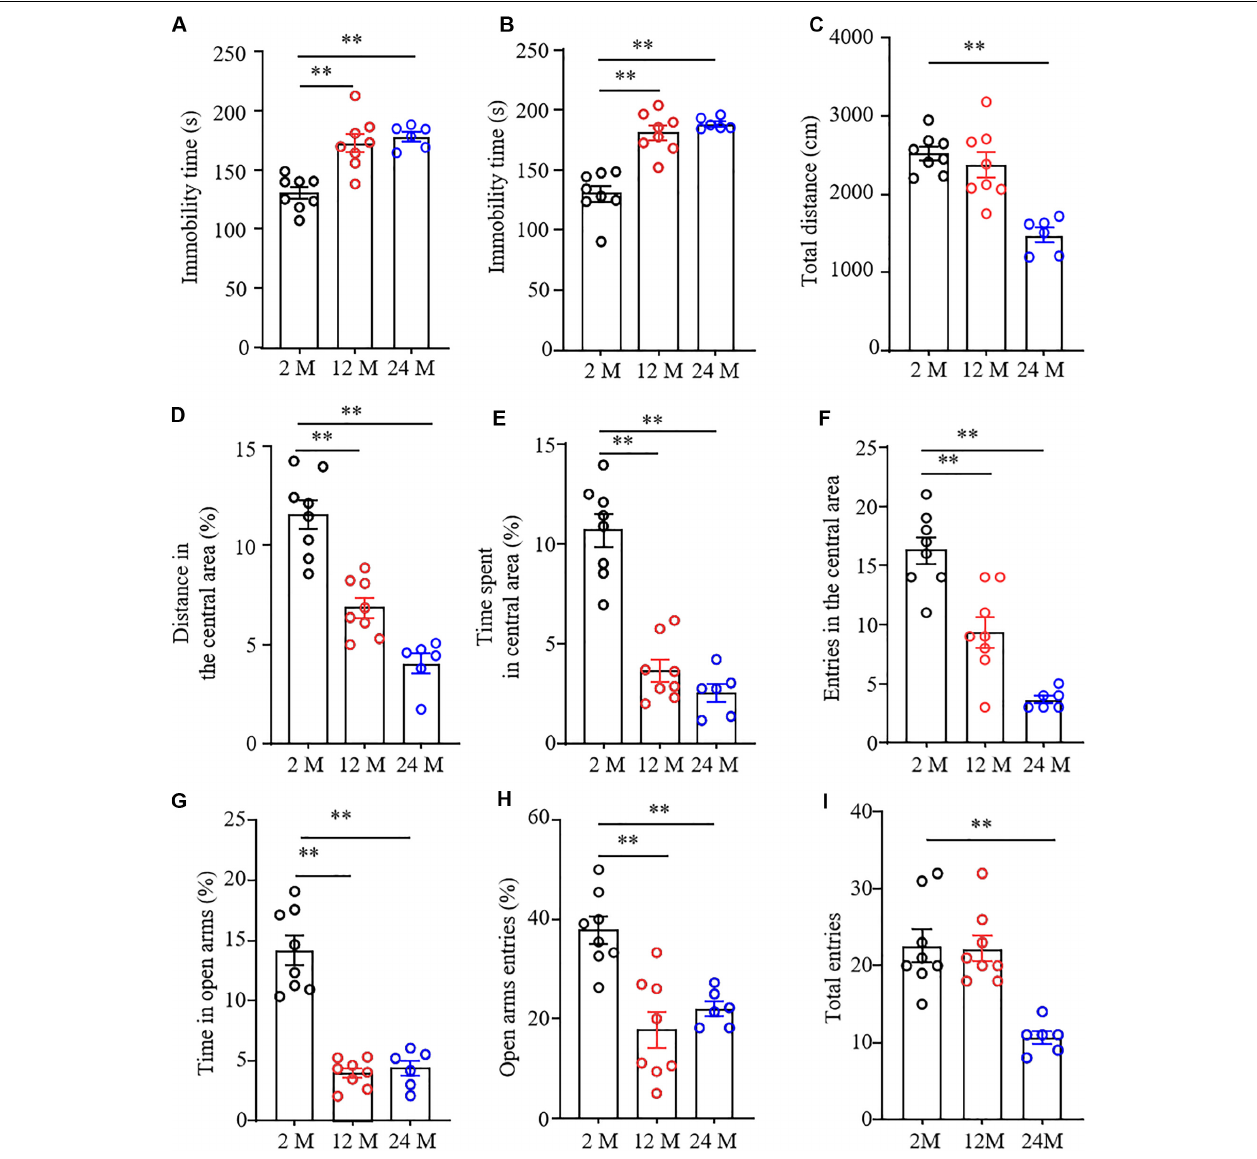
FIGURE 2 | Depression- and anxiety-like behavior in aging mice. n = 8 for 2- or 12-month mice, n = 6 for 24-month mice. Data were shown as mean ± SEM. (A,B) The immobility time was significantly increased in 12- and 24-month old mice in the forced swimming test (FST) (A) and tail suspension test (TST) (B) as compared to 2-month old mice. ∗∗ P < 0.01 versus 2-month old mice by one-way ANOVA with repeated measures followed by post hoc Tukey test. (C) The total distance of 24-month-old mice in the open field test was less than that of 2-month-old mice. ∗∗ P < 0.01 versus 2-month old mice by one-way ANOVA with repeated measures followed by post hoc Tukey test. (D–F) The percentage of distance in the central area (D) , the time spent in the central area (E) , and the entries in the central area (F) were significantly reduced in 12- and 24-month old mice in the open field test as compared to 2-month-old mice. ∗∗ P < 0.01 versus 2-month old mice by one-way ANOVA with repeated measures followed by post hoc Tukey test. (G,H) The percentages of the time spent in open arms (G) and open arms entries (H) were both significantly reduced in 12- and 24-month old mice as compared to 2-month old mice in the elevated plus maze test. ∗∗ P < 0.01 versus 2-month old mice by one-way ANOVA with repeated measures followed by post hoc Tukey test. (I) The total arm entries of 24-month old mice were less than those of 2-month old mice. ∗∗ P < 0.01 versus 2-month old mice by one-way ANOVA with repeated measures followed by post hoc Tukey test.